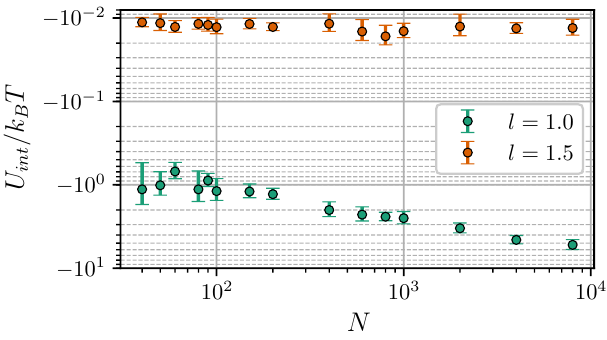
Figure 6. Interaction energy of two clusters vs. the number of cores per cluster. Simulation results for ξ = 0, λ = 3, and ϕ = 0.3. Different colors correspond to different intercluster separations (see